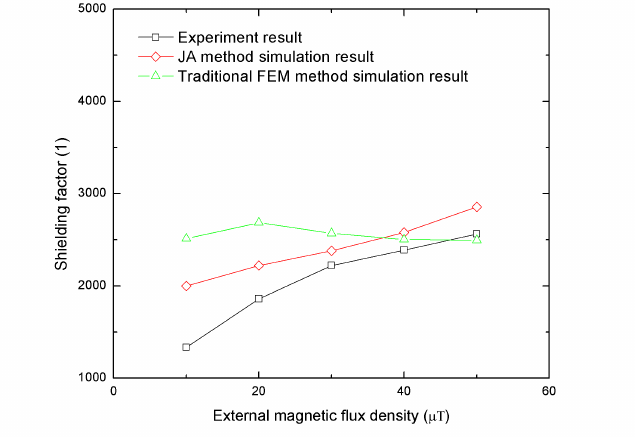
Figure 4. The shielding factors of the MSR at HIT when the frequency of the external field is 0.01